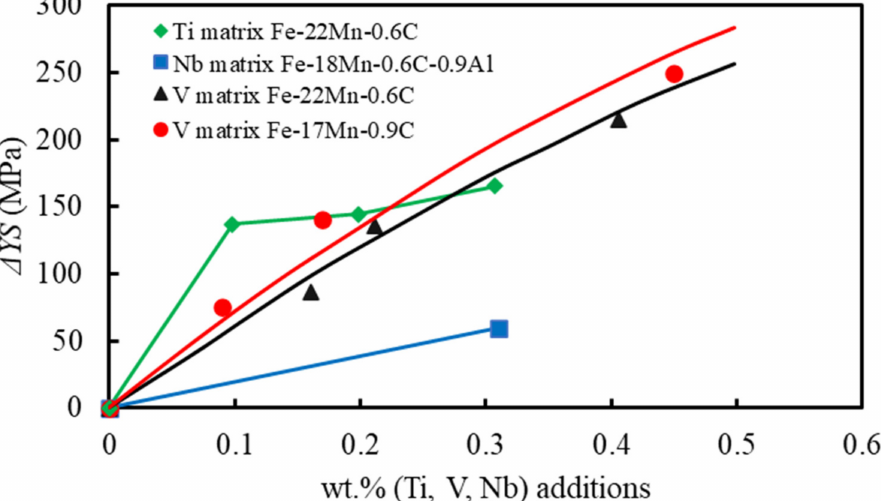
Figure 25. A comparison of the room temperature yield strength increases in TWIP steels for cold rolled and annealed strips as a function of the microalloying additions, Ti, Nb and V